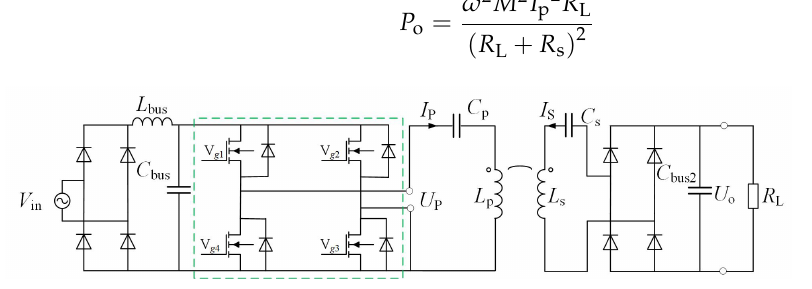
Figure 2. Equivalent circuit model of an IPT system designed for kitchen